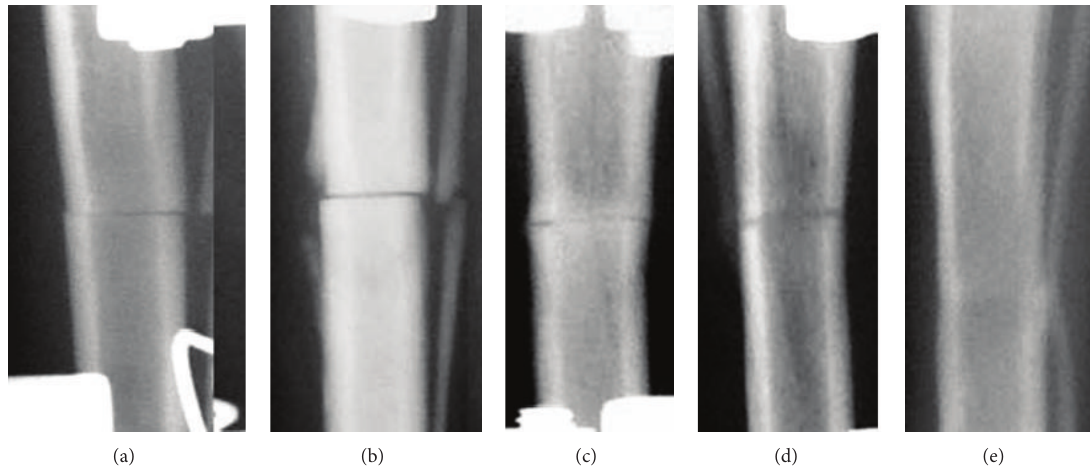
Figure 1: Group 1 radiographs: (a) day 7, (b) day 14, (c) day 30, (d) day 45, and (e) day 75.